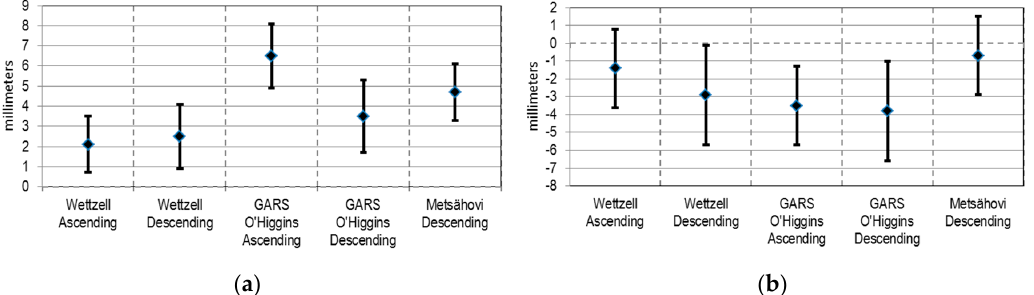
Figure 6. Gradients of the interpolated linear trends at the different test sites: ( a ) range; ( b ) azimuth. The plotted error bars represent a 95% confidence interval (2 σ ). Table 4. Interpolated linear trend of the observed offsets: Mean value and standard deviation (1 σ ) of the gradient.